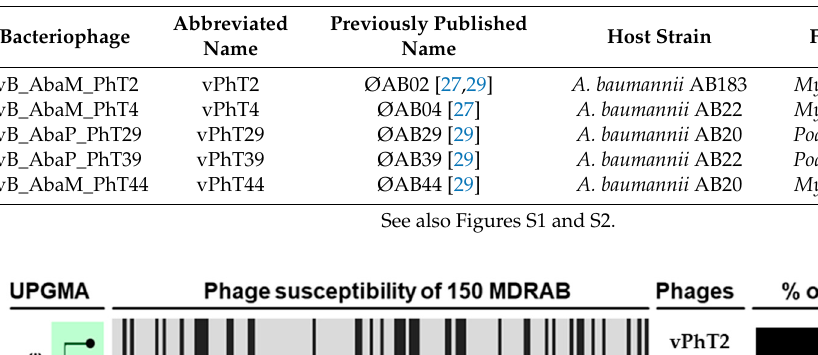
Table 1. Overview of properties of Acinetobacter baumannii bacteriophages with broad host ranges.